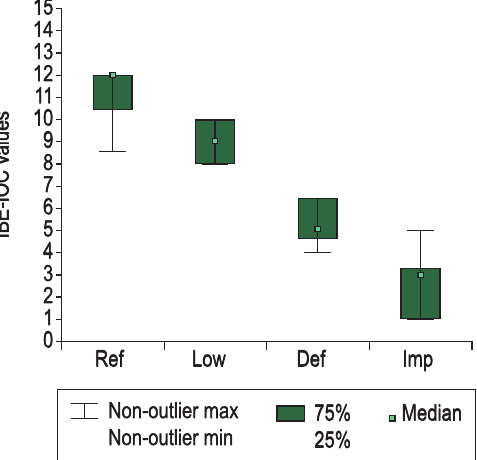
Figure 2. Box-and-whisker plots with the values of IBE-IOC calculated for streams of the four levels of environmental integrity: Ref (reference) 6 samples, Low (low impaired) 6 samples, Def (deforested) 6 samples and Imp (impaired) 24